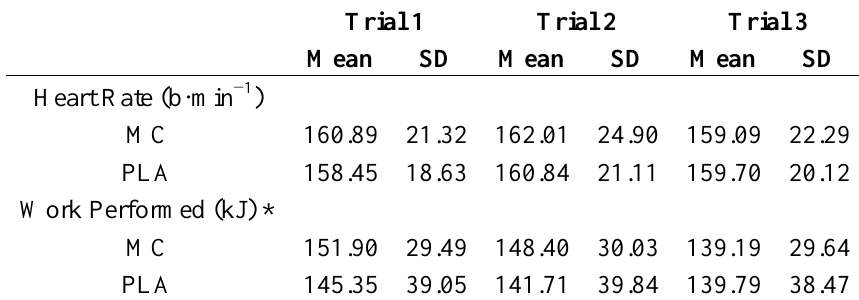
Table 3. Time trial